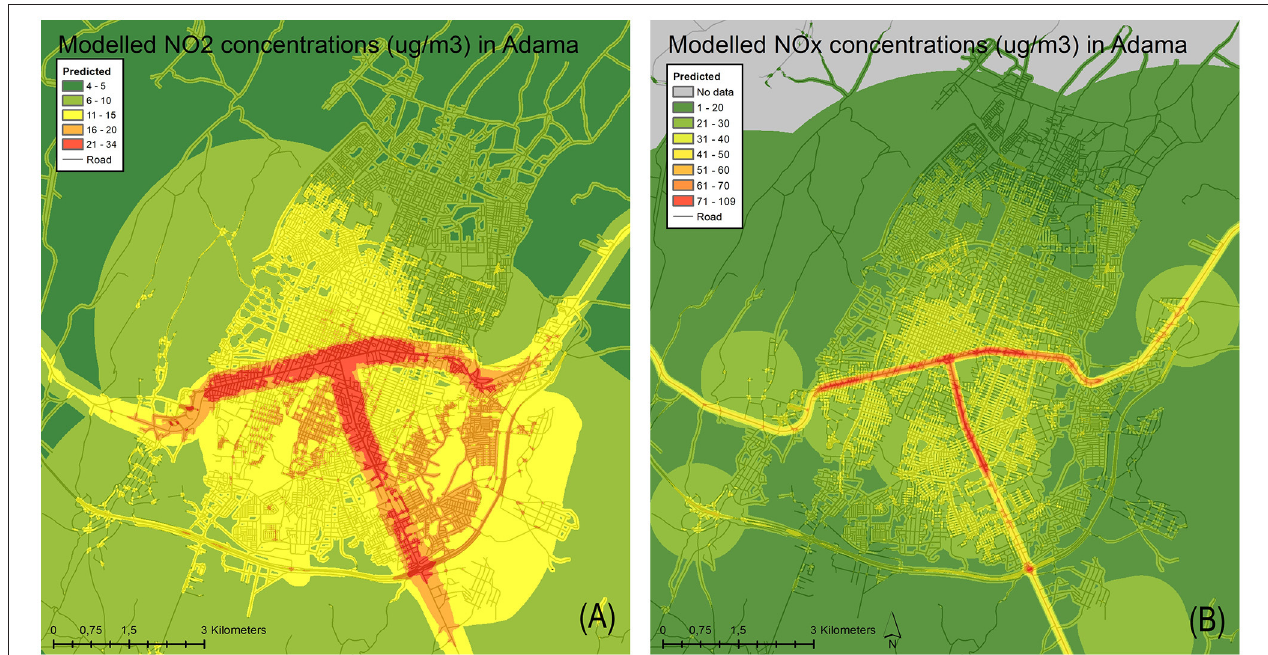
FIGURE 2 | Modeled concentrations of NO 2 (left) and NO x (right) , measured in µ g/m 3 , throughout Adama, Ethiopia.